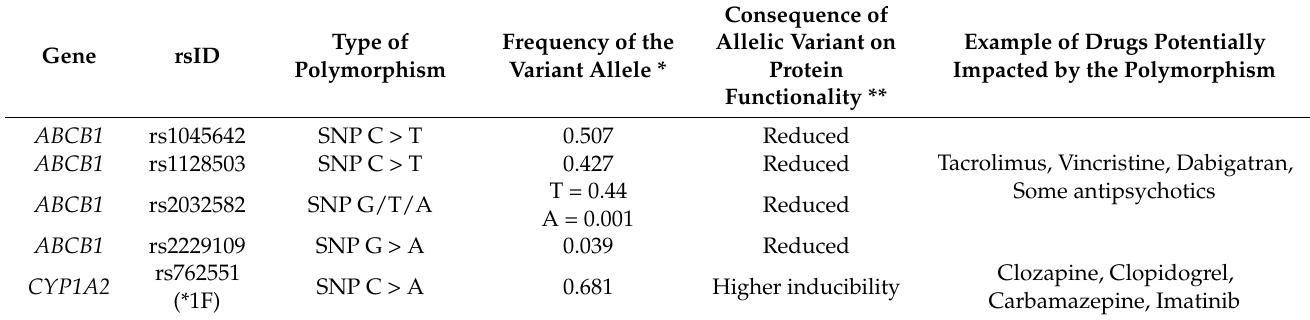
Table 1. Genetic variants of interest included in the panel of the multiplex